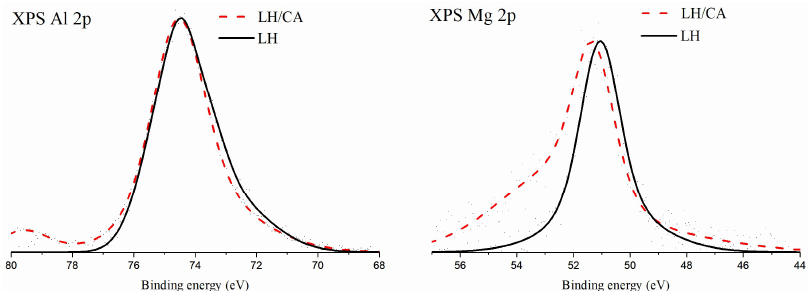
Figure 1. X-ray photoelectron spectra of Al 2p transition ( left panel) and Mg 2p transition ( right panel) acquired for aluminum-magnesium hydroxycarbonate (LH) before (black line) and after (red line) modification with carminic acid (20%).